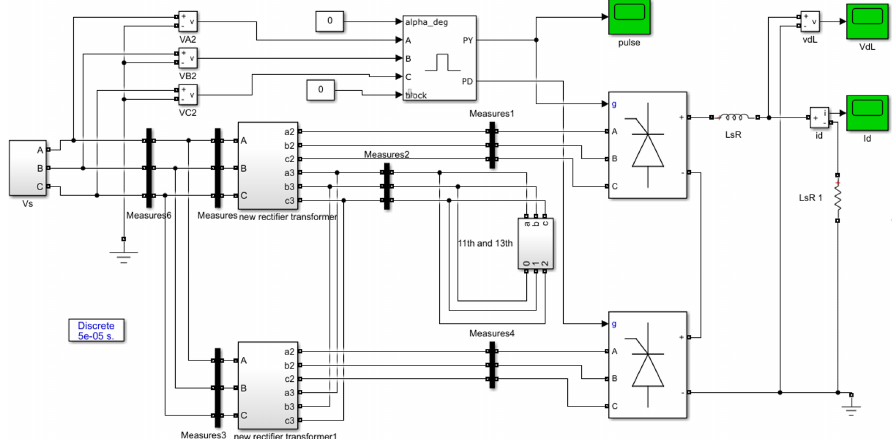
Figure 5. Simulation model of an integrated multi-winding inductive filter converter transformer and its filter